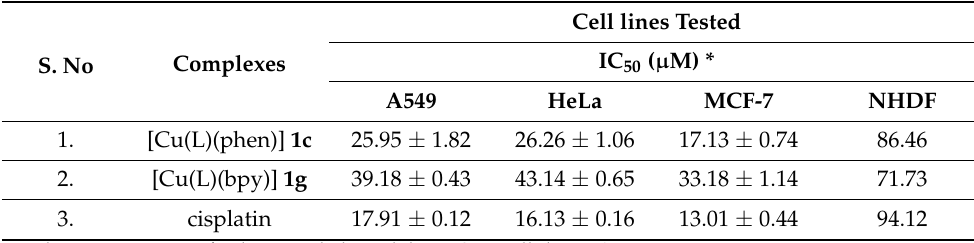
Table 12. In vitro anticancer activity of metal(II) complexes 1c and 1g against A549, HeLa, and MCF-7 cancer